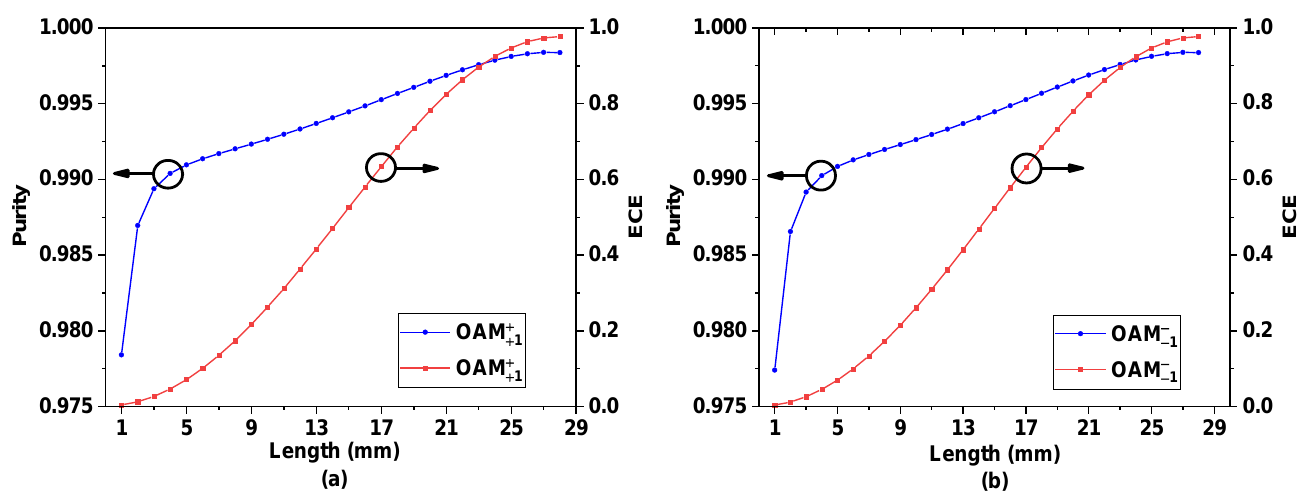
Figure 8. ( a ) Purity and energy conversion efficiency (ECE) of +1 order OAM mode with CPFM input. ( b ) Purity and energy conversion efficiency (ECE) of − 1 order OAM mode with CPFM input.